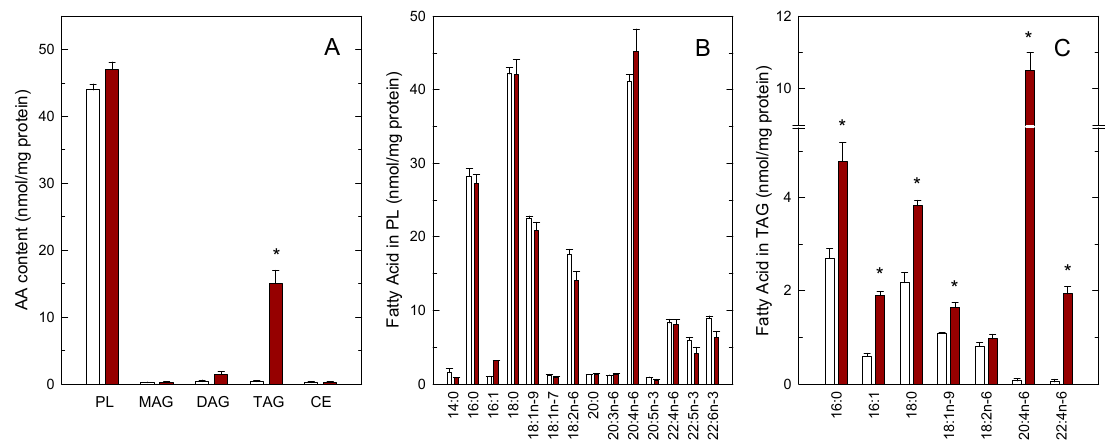
Figure 1. Arachidonic acid (AA) incorporation into the lipids of human monocytes. Monocytes were either untreated (open bars) or treated with 10 µM AA for 2 h (maroon bars). Afterwards, the various lipid classes were isolated and their AA content was measured by GC/MS after converting the fatty acid glyceryl esters into fatty acid methyl esters ( A ), the full profile of fatty acids of phospholipids ( B ) and triacylglycerol (TAG) ( C ) is also shown. Fatty acids are designated by their number of carbon atoms and, after a colon, their number of double bonds. To differentiate isomers, the n − x ( n minus x) nomenclature is used, where n is the number of carbons of a given fatty acid, and x is an integer which, subtracted from n gives the position of the last double bond of the molecule. Results are shown as means ± SEM. ( n = 3). * p < 0.05, significantly different from AA-untreated cells.